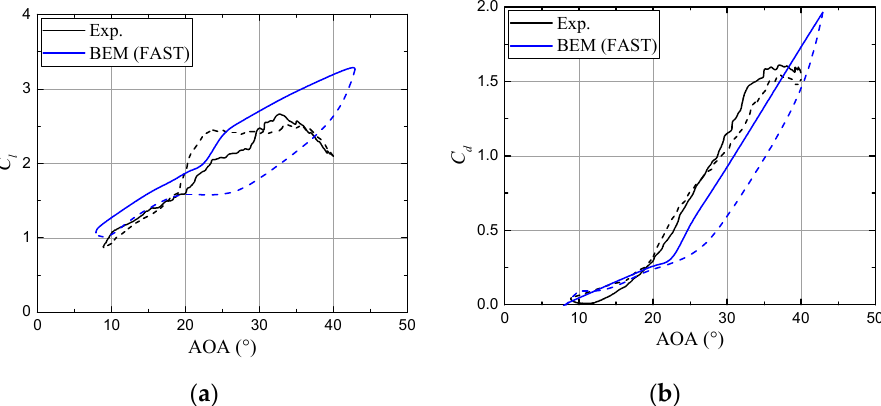
Figure 19. Comparison between the experimental aerodynamic coefficients and the calculated data with both rotational augmentation and dynamic stall models used in the BEM code. r / R = 30%, V w = 13 m/s, and ϕ y = 30°. Solid lines denote increasing AOA, and dashed lines decreasing AOA. ( a ) 3D C l ; ( b ) 3D C d .